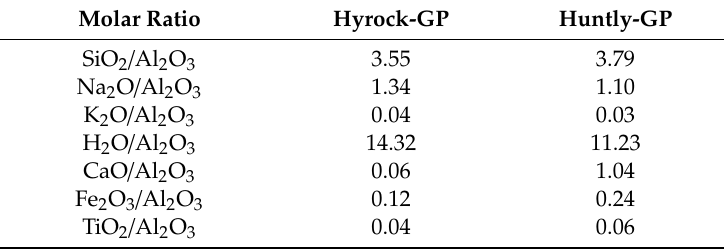
Table 5. Molar compositions of the fly ash-based geopolymer precursors a . Molar